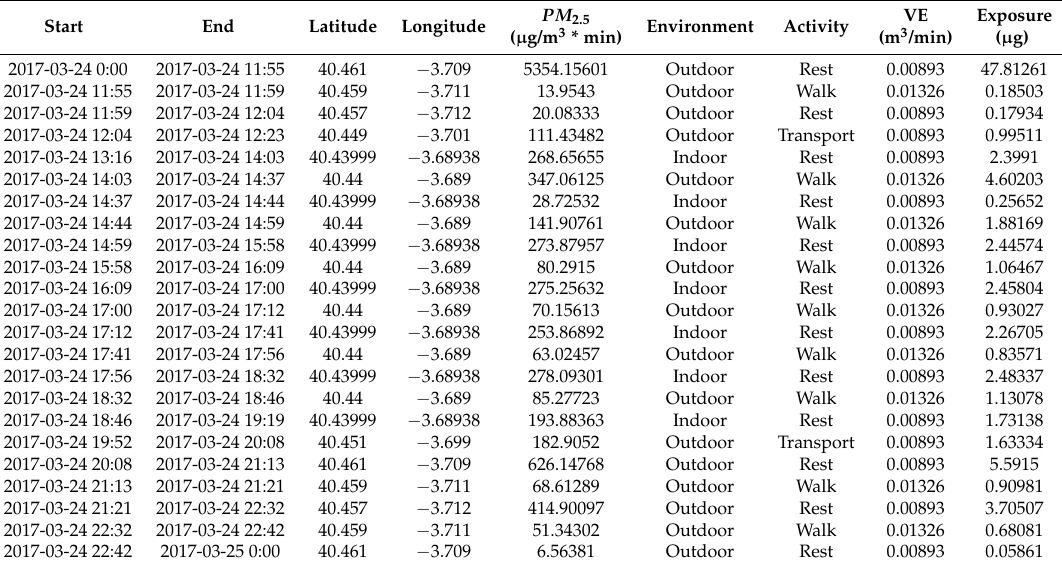
Table 5. Integrated Indoor and Outdoor Personal Air Pollution Exposure